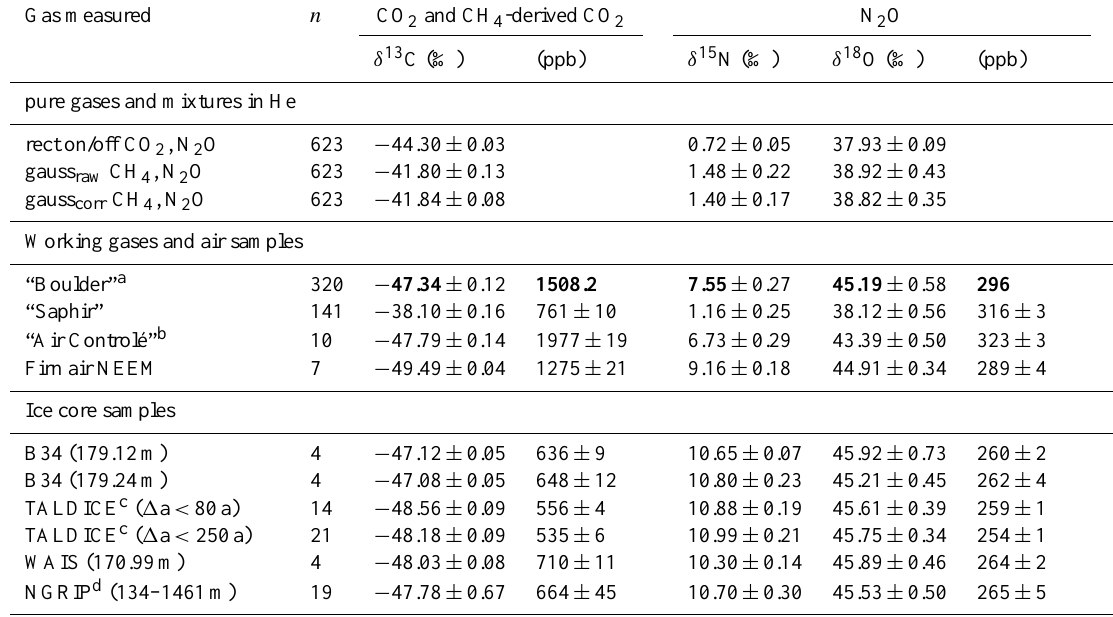
a Values in bold are the assigned numbers of the isotopic ratios from Table 2, while the reported 1 σ values are derived from the measured time series. For the mixing ratios, only the assigned numbers are reported, since here the time series is used to calculate time-dependent response curves. b “Air Controlé” values reported here are treated as a sample and calibrated against “Boulder”. Therefore, these values may slightly deviate from the assigned ones in Table 2. c For TALDICE the replicate means are shown to put the measured reproducibility into perspective; the reported mean for each parameter is the average of all replicate pairs of the measured time interval (2kyr to 100kyr). Note that the reproducibility ( ± value) for TALDICE samples represents the median standard deviation of pairs of “vertical neighbouring replicates”; see Sect. 5.3 for details. d The samples from the North Greenland Ice Core Project (NGRIP) are not replicates but single samples covering 10000 years. Note that a few samples show highly elevated CCl 2 F 2 levels (Table 4), but no sample was removed from the calculations as the other parameters seem unrelated to the CCl 2 F 2